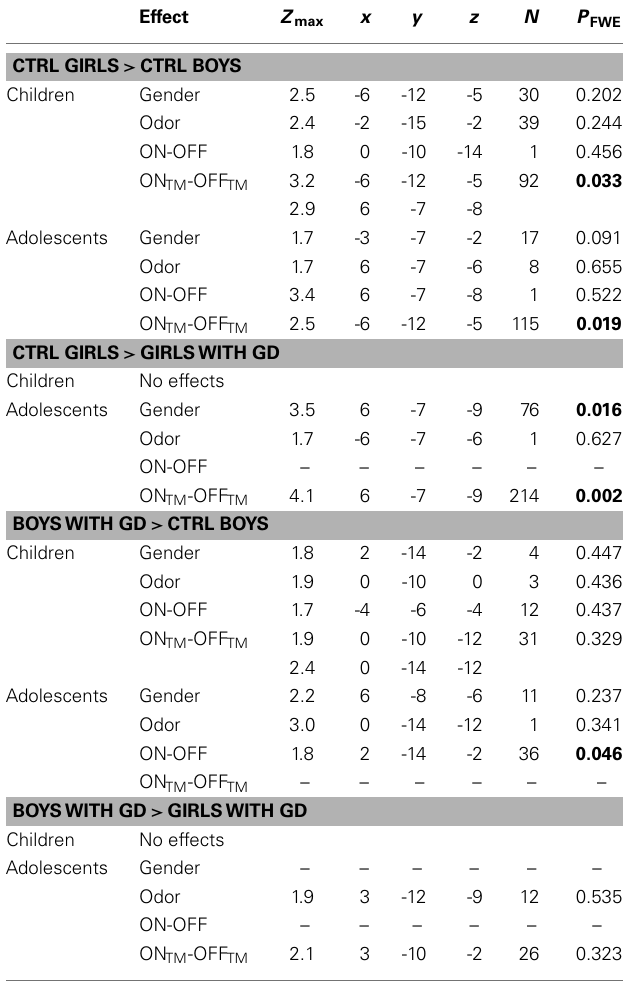
Table 2 |ANOVA results showing sex differences in hypothalamus activations in the control groups, and sex-atypical hypothalamic activations, reflecting their experienced gender, in individuals with GD